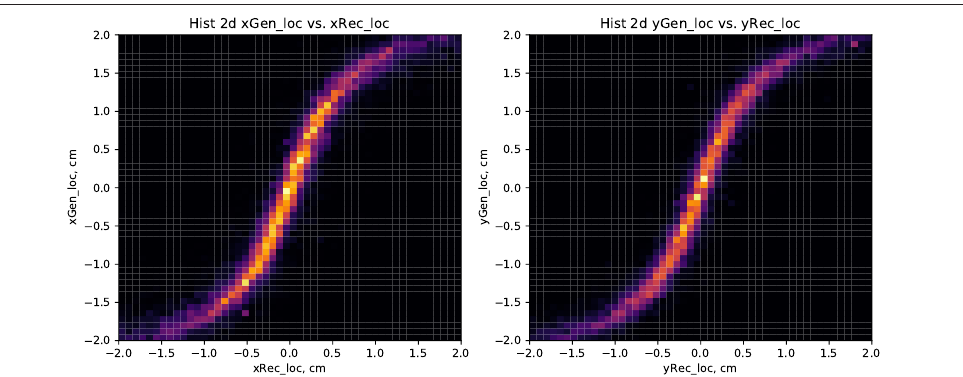
Figure 1. The dependence (2-dimensional distribution) of local coordinates of signal cluster barycentre on true coordinates of the hit position for inner modules. The local coordinates are of x (left) and y (right). Here and in the Figure 2 colour from violet (dark) to yellow (bright) represents the normalised counts of the events from 0.0 to 1.0, respectively.